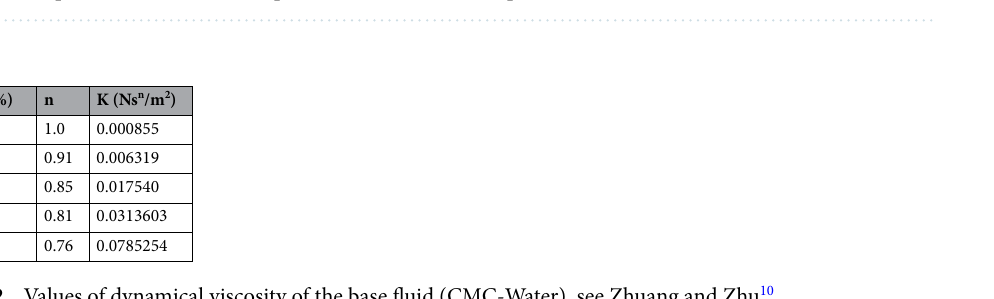
Table 1. Properties of the base fluid, porous medium and nanoparticles; see Shah et al. 54 .